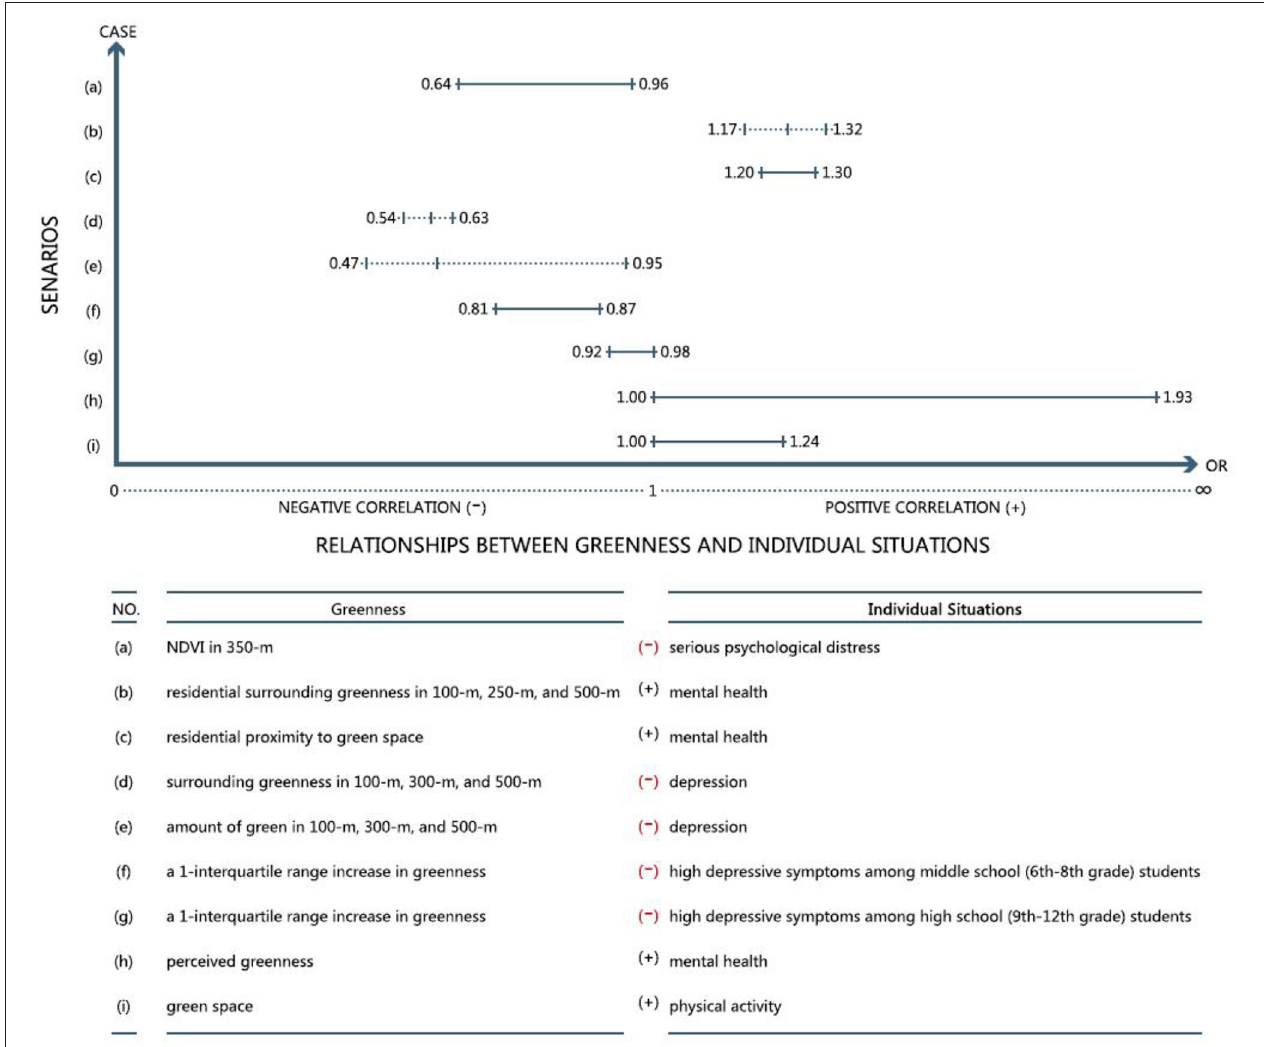
FIGURE 2 | By searching data from the previous studies, the relationship between greenness and individual situation (see Appendix A for references) is reflected by odds ratios (ORs). If the OR < 1, it means that there is a negative correlation between the two factors. And it will be positive between two factors if the OR is more than one. There are four pairs of relationships that are positively correlated: (b) residential surrounding greenness and mental health, (c) residential surrounding greenness and mental health, (h) perceived greenness and mental health, and (i) green space and physical activity, which indicate that greenness will promote mental health and physical activity. In addition, negative correlations of scenarios with mental problems are: (a) NDVI over 350m, which represents the greenness assessed by the Normalized Difference Vegetation Index (NDVI) surrounding a residence over 350m, (d) surrounding greenness over 100, 300, and 500m, (e) amount of green over 100, 300, and 500m, and (f) (g) a 1-interquartile range increase in greenness. The solid lines represent the range of the relationship, and the dashed lines indicate the potential range of the